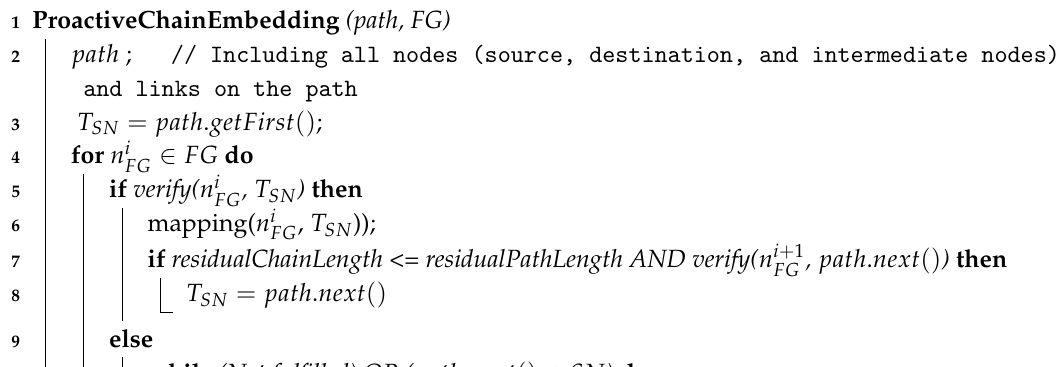
Algorithm 4: Proactive chain embedding